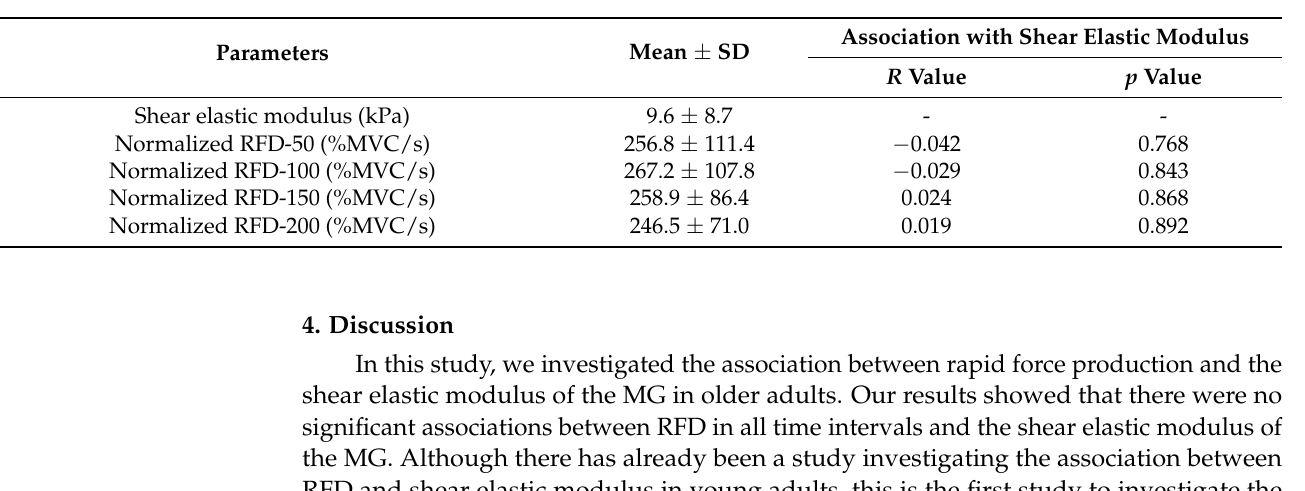
Table 1. The outcome variables and partial correlations between shear elastic modulus of medial gastrocnemius and rate of force development (RFD) at all time